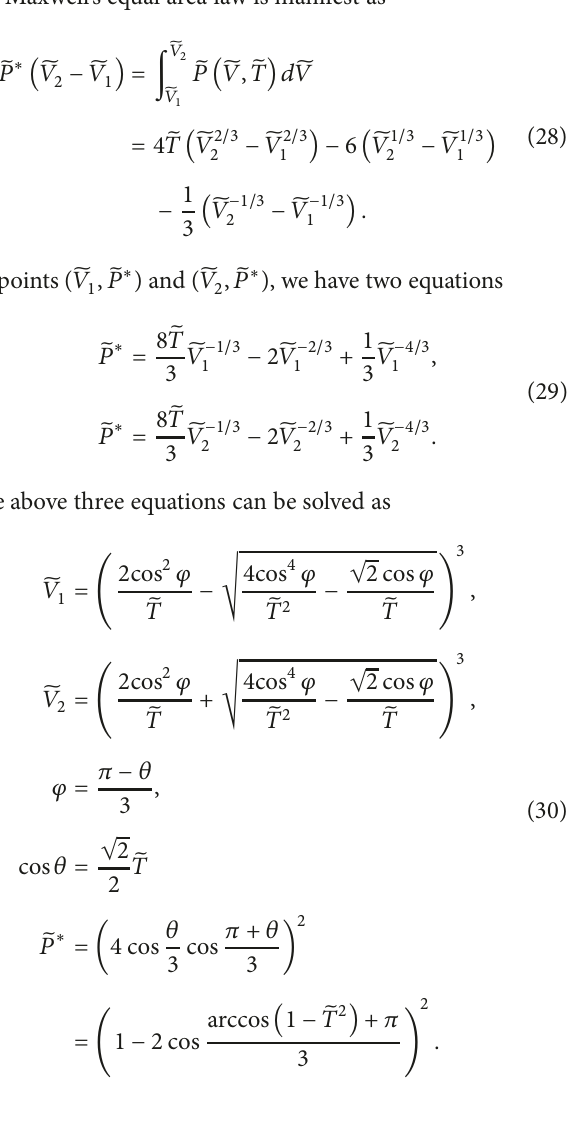
̃𝑇 = 0.870155,1.0,1.1 ̃𝑃 ̃𝑉 Figure 4: vs. for ̃𝑇 ≤ 1.0 takes place for . The dashed black line separatesthe oscillatory part. According to Maxwell’s equal area law, (̃𝑇 = 0.870155, ̃𝑃 = 0.7) the phase transition point is